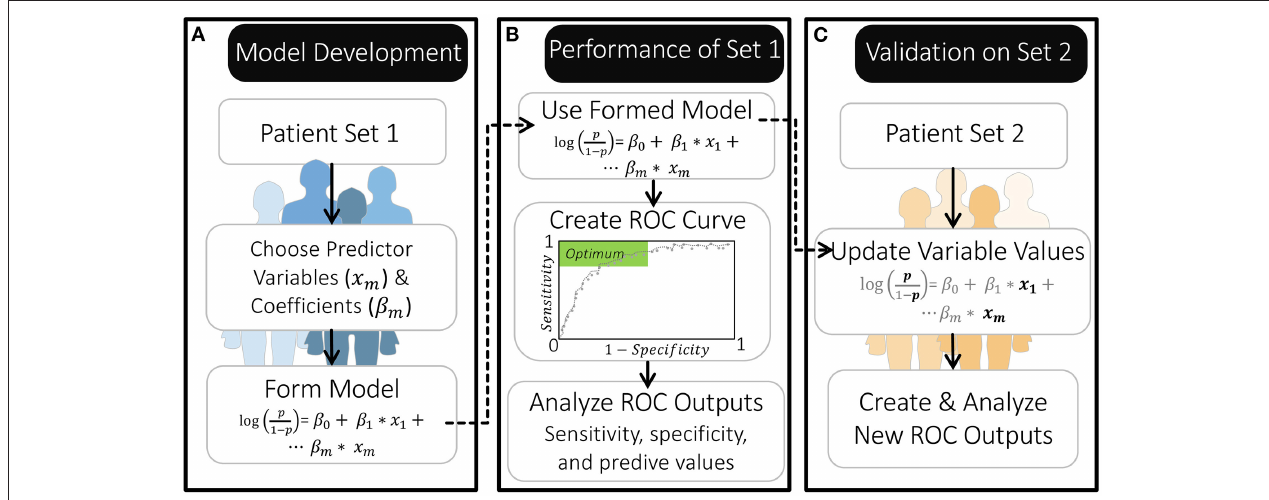
FIGURE 2 | Overview of model development and validation by Nnoaham et al. (25). (A) The authors created their models using a set of 771 patients. (B) They then evaluated the performance of this model using a ROC curve to identify probability thresholds for classification that produce a specificity and sensitivity within the optimal range. (C) They further validated the model by first updating it with new predictor variable values for a separate set of 625 patients (leaving the β coefficients as they were) and then creating a new ROC